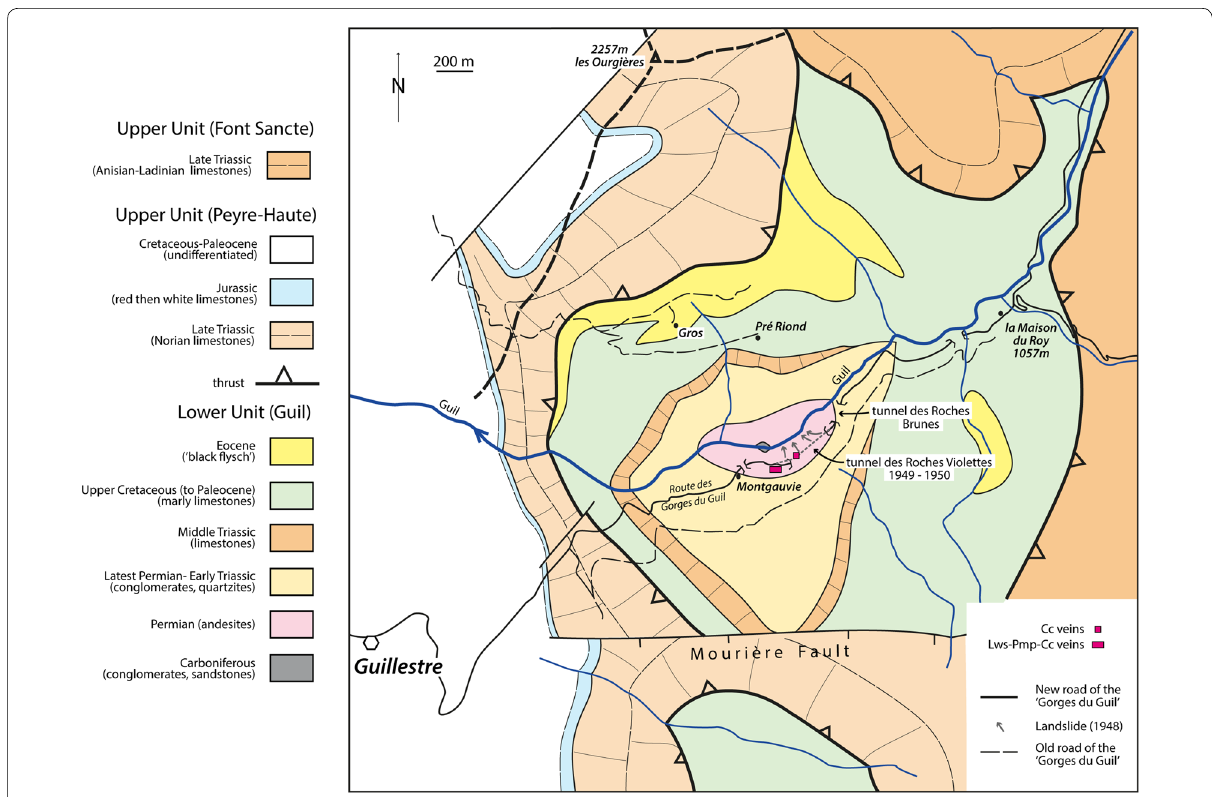
Fig. 3 Simplified geological map of the Guil anticline (modified from Blanchet 1934; Debelmas et al. 1966; Kerckhove et al. 2005). The Mourière Fault, not shown on the 1/5000 geological sheets, is taken from M. Gidon (www.geol-alp.com). For sake of clarity, only the solid geology is shown: all Quaternary sediments (screes, alluvial deposits, moraines, …) are ignored in order to better display the geometry of the nappe